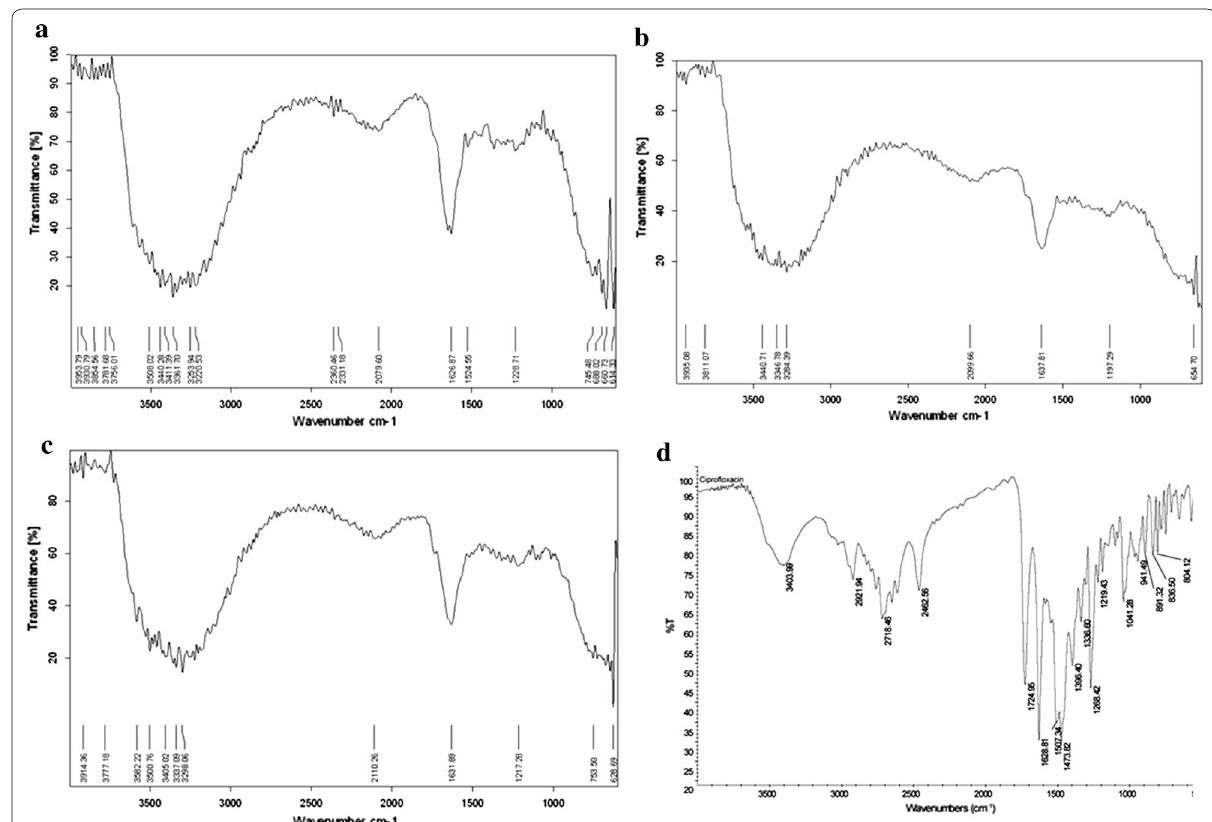
Fig. 2 FTIR spectra of a callus extract of F. indica , b callus extract mediated AgNPs, c ciprofloxacin ciprofloxacin as